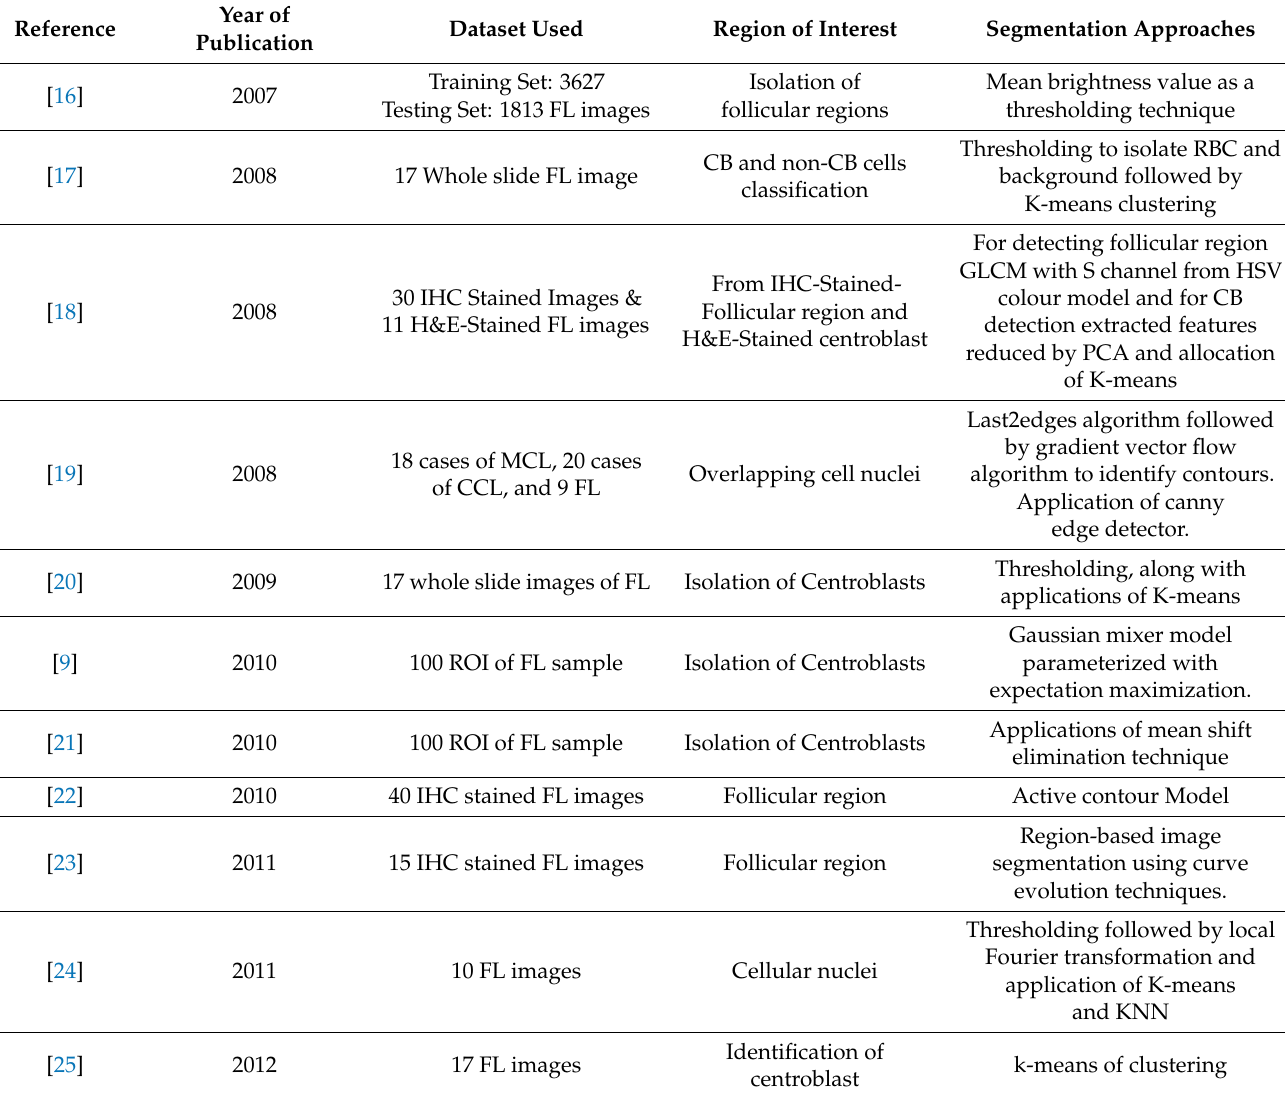
Table 1. Systematic review for segmenting FL